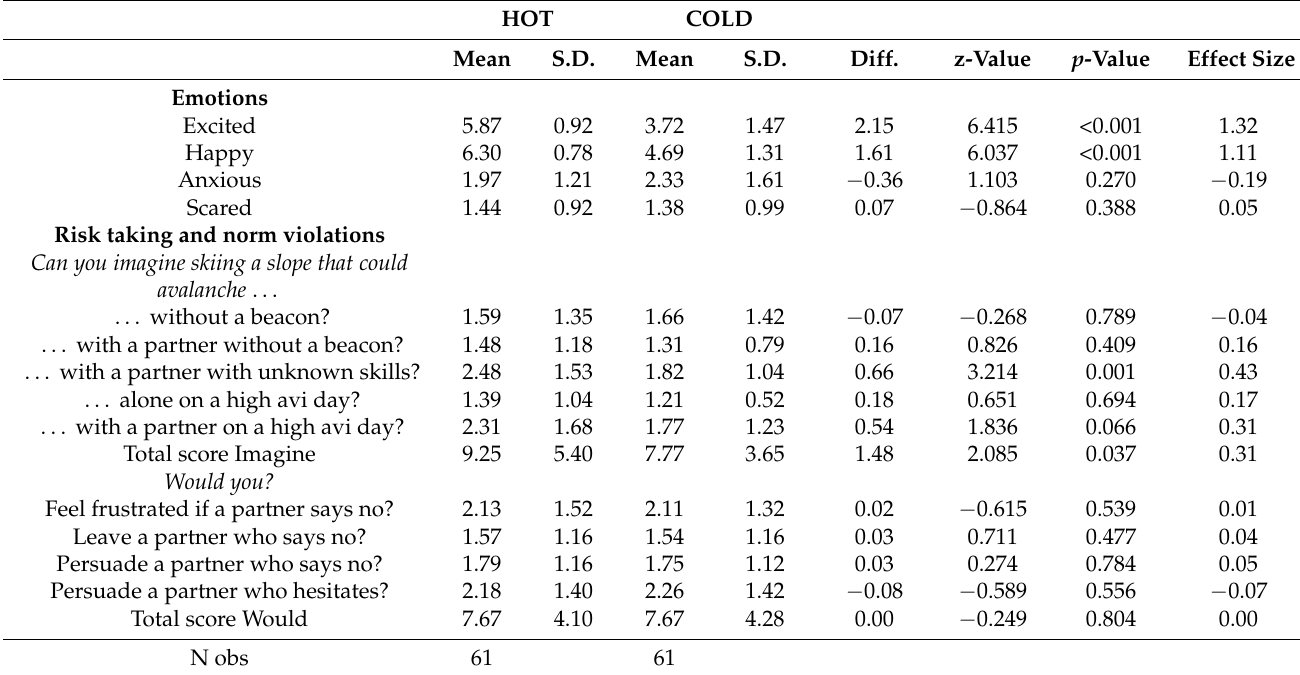
Table 8. Mean responses in hot and cold states (group 2). Wilcoxon signed rank